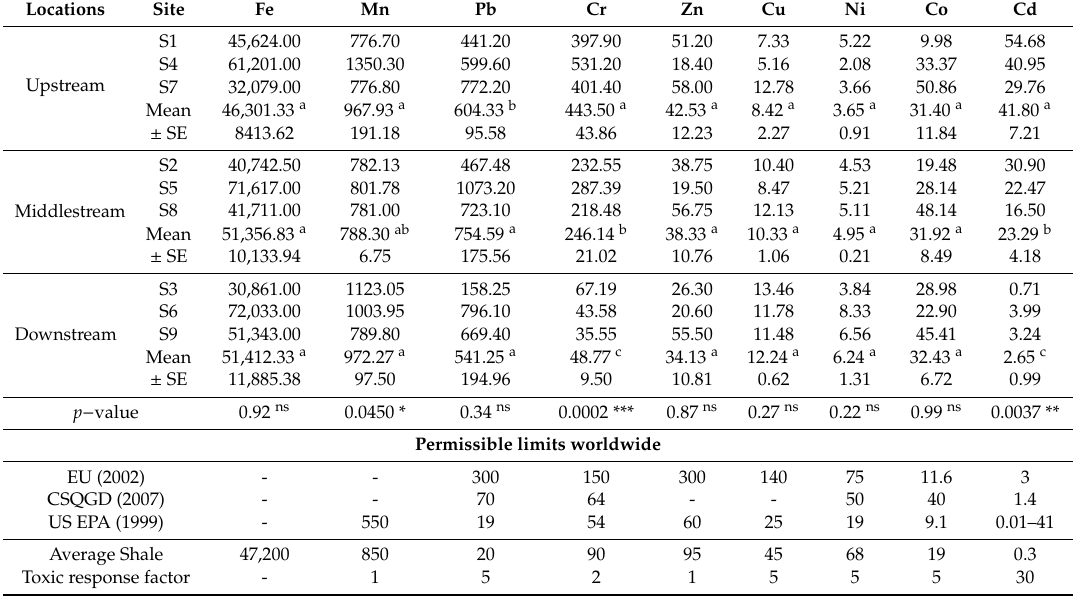
Table 2. Heavy metal concentrations (mg / kg) in sediment samples from di ff erent sites (S1–S9) representing the three main drains of the Burullus